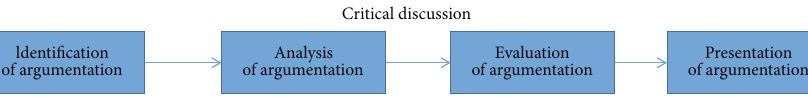
Figure 15: Schematic diagram of critical discussion process. Table 3: BOPPPS-based college English audiovisual speaking test